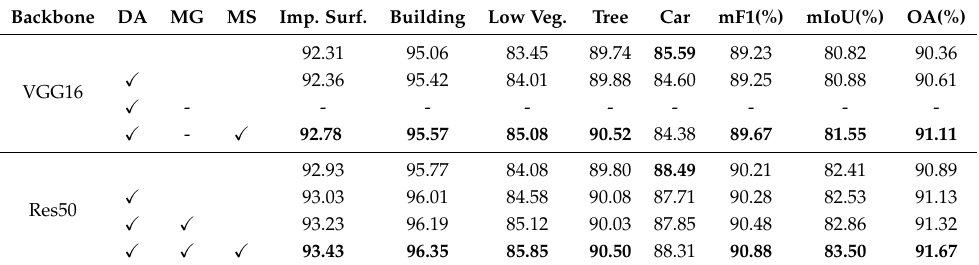
Table 6. Performance comparison between different improvement strategies on Vaihingen dataset. Backbone DA MG MS Imp. Surf. Building Low